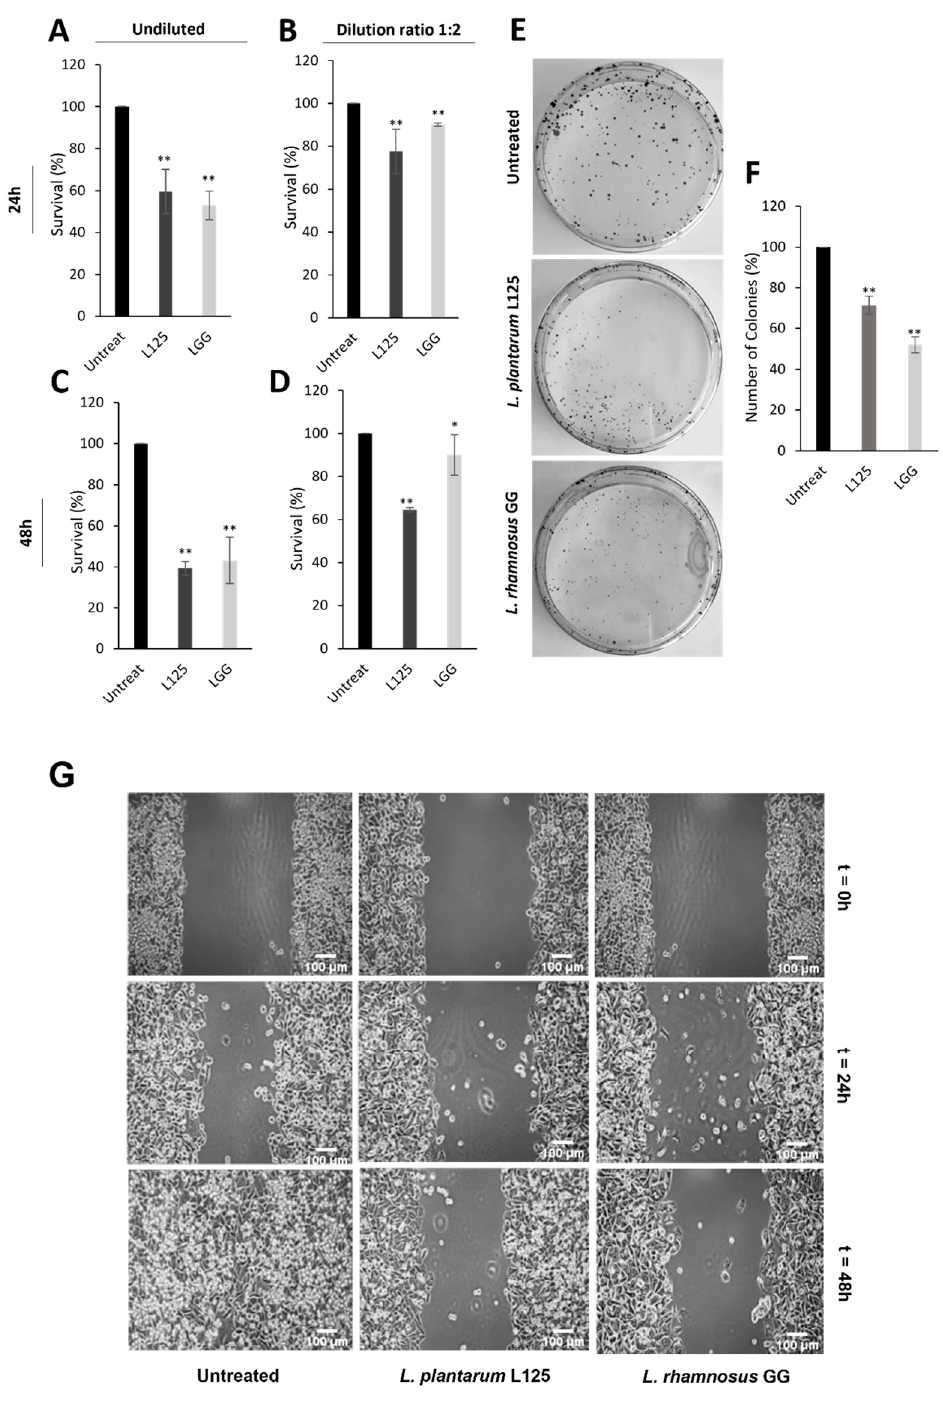
Figure 7. Time- and dose-dependent anti-proliferative, anti-clonogenic and anti-migration activity of L. plantarum L125-derived CFCS against the human adenocarcinoma cell line, HT-29. L. rhamnosus GG was used as a reference. The SRB colorimetric assay was used to evaluate the anti-proliferative activity of undiluted ( A , C ) or diluted at a ratio of 1:2 ( B , D ) L. plantarum L125 or L. rhamnosus GG-derived CFCS, after 24 ( A , B ) or 48 ( C , D ) hour treatments. ( E ) Representative photos of the colony formation assay results, showing the anti-clonogenic potential of undiluted L. plantarum L125 and L. rhamnosus GG CFCS after 48 h treatments. ( F ) Quantitative results of the colony formation assay for the reference and tested strain. ( G ) The anti-migration capacity of L. plantarum L125- or L. rhamnosus GG-derived CFCS, evaluated by the wound healing assay. Photos were taken at 0, 24 and 48 h post-incubation with undiluted CFCS. Scale bar, 100 μ m. Data are presented as the mean ± standard deviation. * p < 0.05, ** p < 0.001 compared to control, untreated cells.